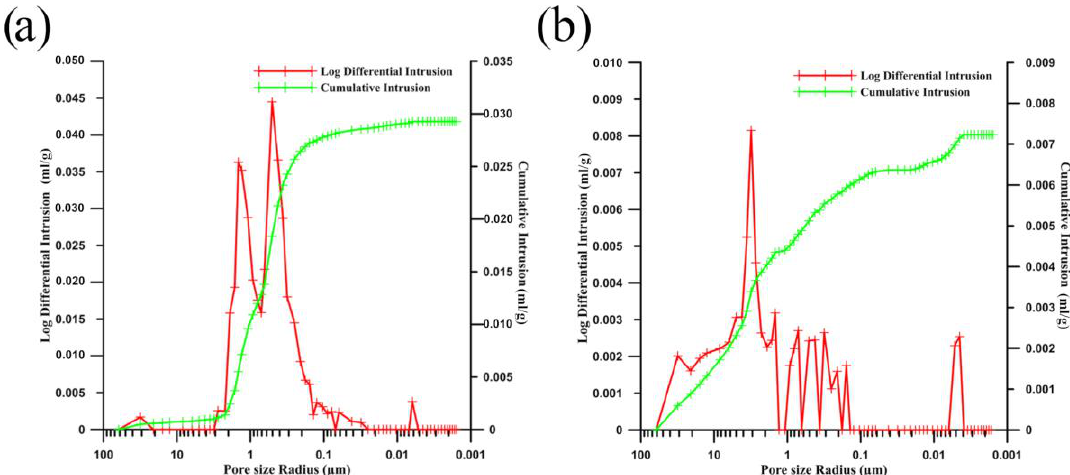
Figure 6. Porosity measurement of ( a ) the zinc composite with a characteristic second peak for HA particles porosity (0.1–1 µm) and ( b ) pure zinc with visible volume changes during the measurement. Compared with the Zn matrix in the Zn/HA composite, the pure sintered zinc contained larger pores occurring predominantly on the contacts of the three particles (see Table 2 and Figure 4).